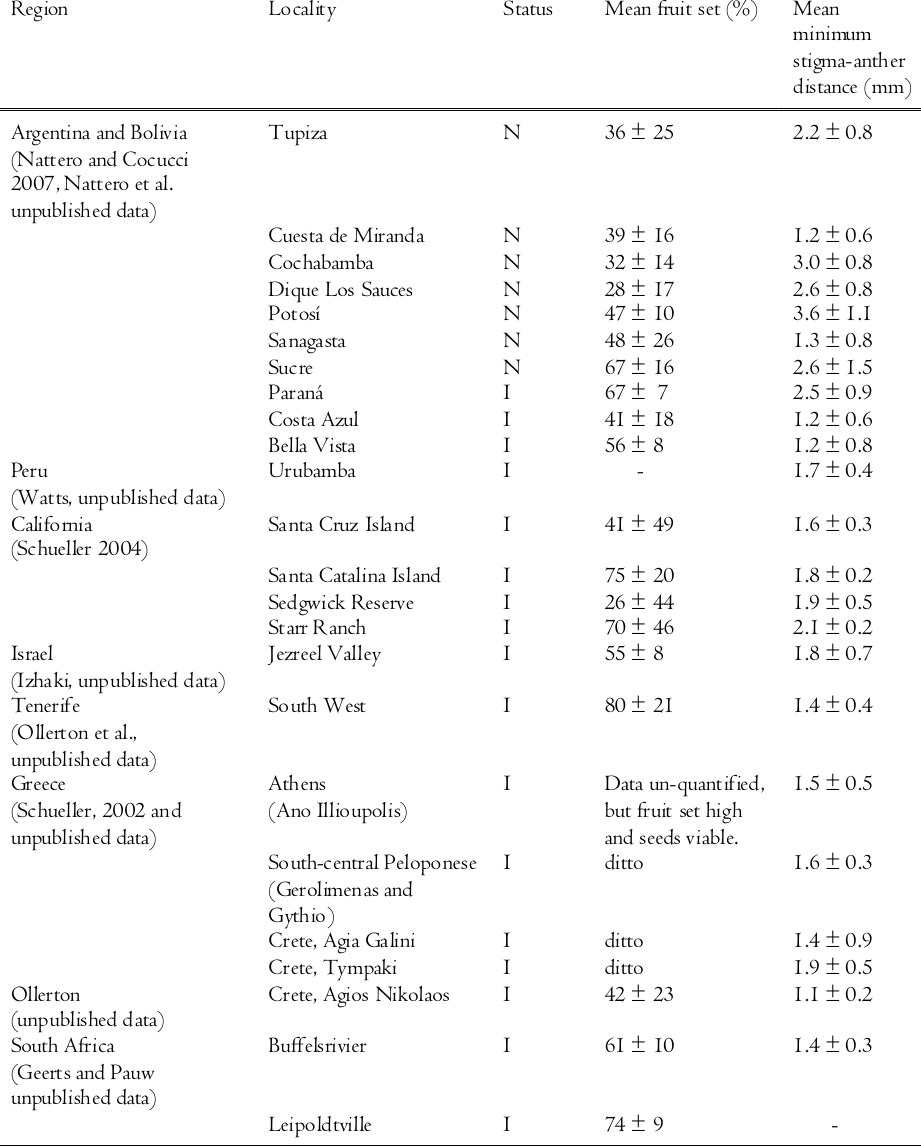
T ABLE 1 : Reproductive output and mean stigma-anther distances of populations of Nicotiana glauca . Stigma-anther distances were measured to the nearest 0.1 mm using a digital calliper. Sample sizes vary considerably and are available from the corresponding author on request. All means are